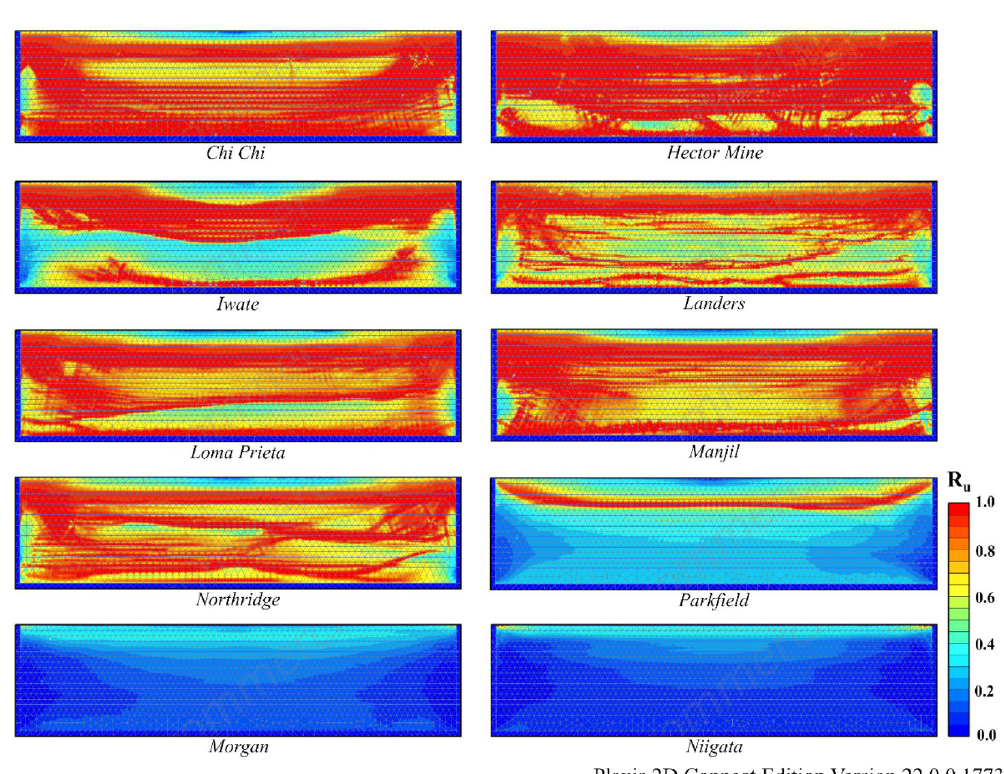
Figure 13. R u results obtained at the end of the vibrations for Model